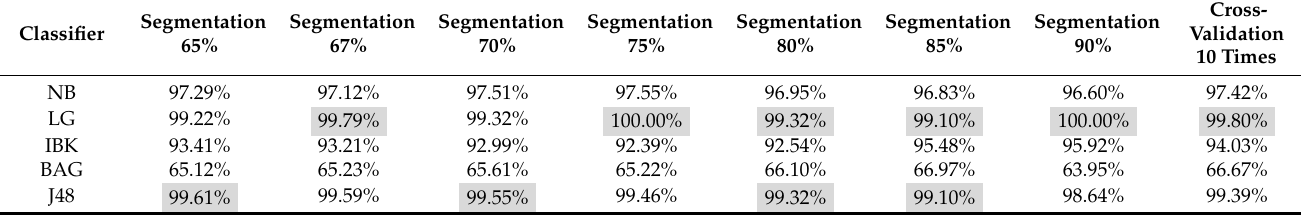
Table 7. The classifier accuracy of no-feature selection for 982 normal and 491 bankrupt companies (2:1).